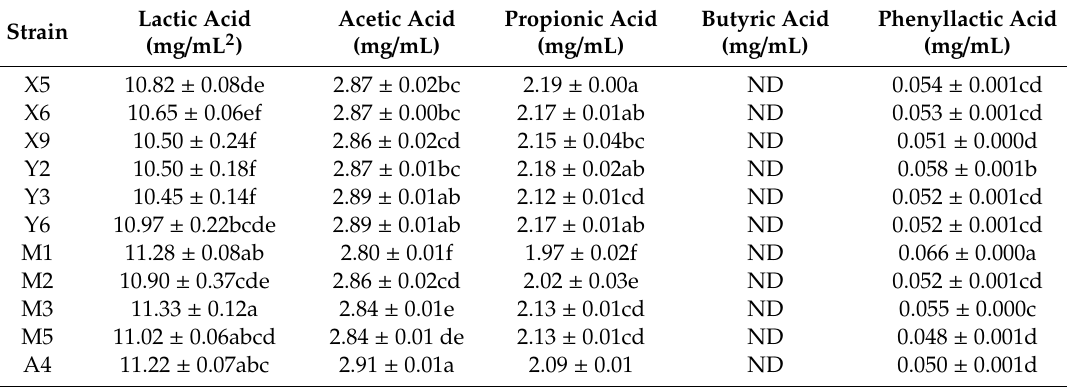
Values with different small row (a–f) show significant differences among acid content in the same column.